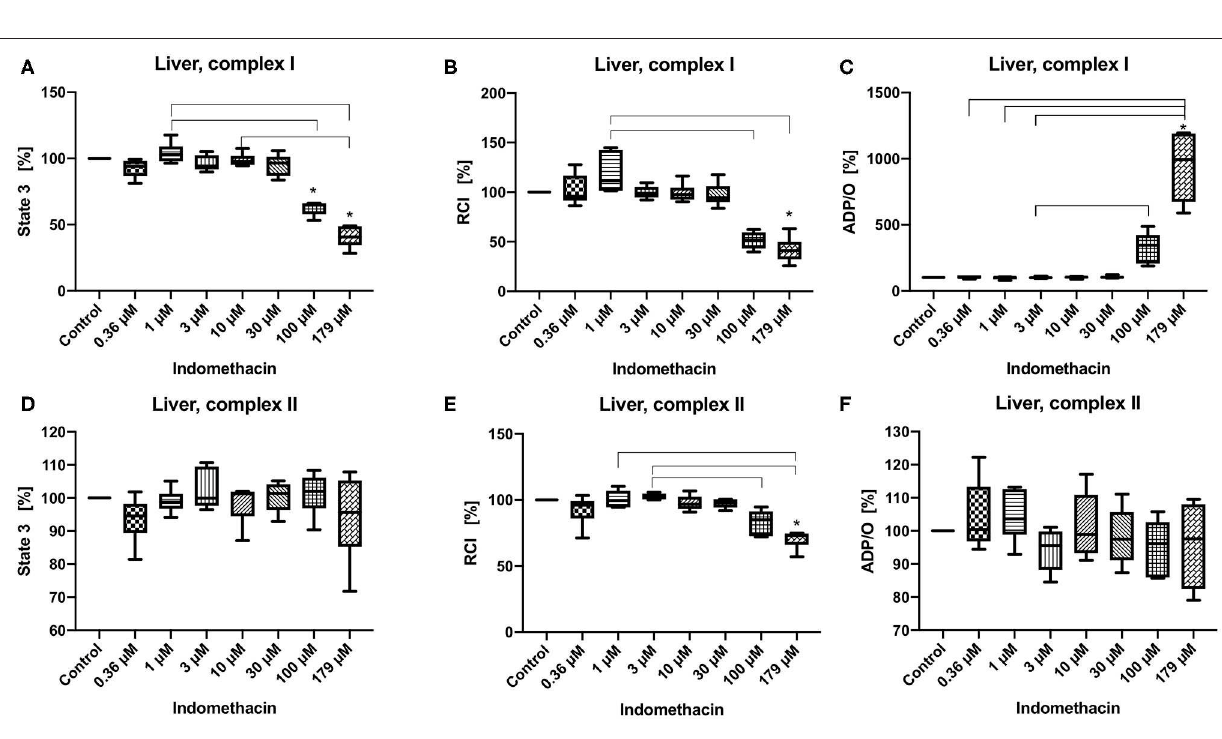
FIGURE 2 | Effect of indomethacin (0.36, 1, 3, 10, 30, 100, and 179 µ M) on hepatic mitochondrial function: State 3 for complex I (A) and II (D) , respiratory control index (RCI) for complex I (B) und II (E) and ADP/O ratio for complex I (C) and II (F) . Data are presented as percentage of the control value (median/min/max), n = 6, * p < 0.05 vs. control, p < 0.05 between